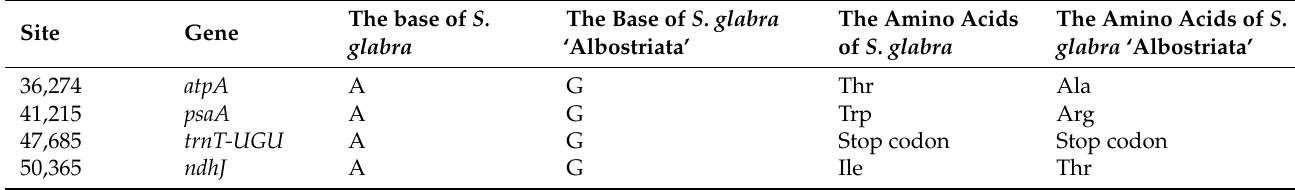
Table 3. The variation in the chloroplast genomes of S. glabra and S. glabra